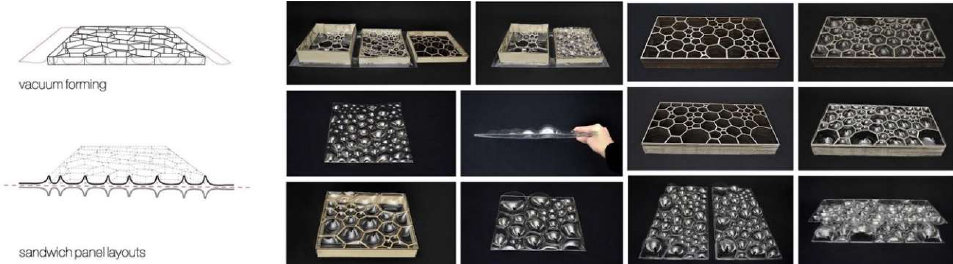
Figure 8. Single and double-layered PETG sandwich panels were fabricated to study the influence of different formwork parameters like materiality, height, and orientation of the mold.